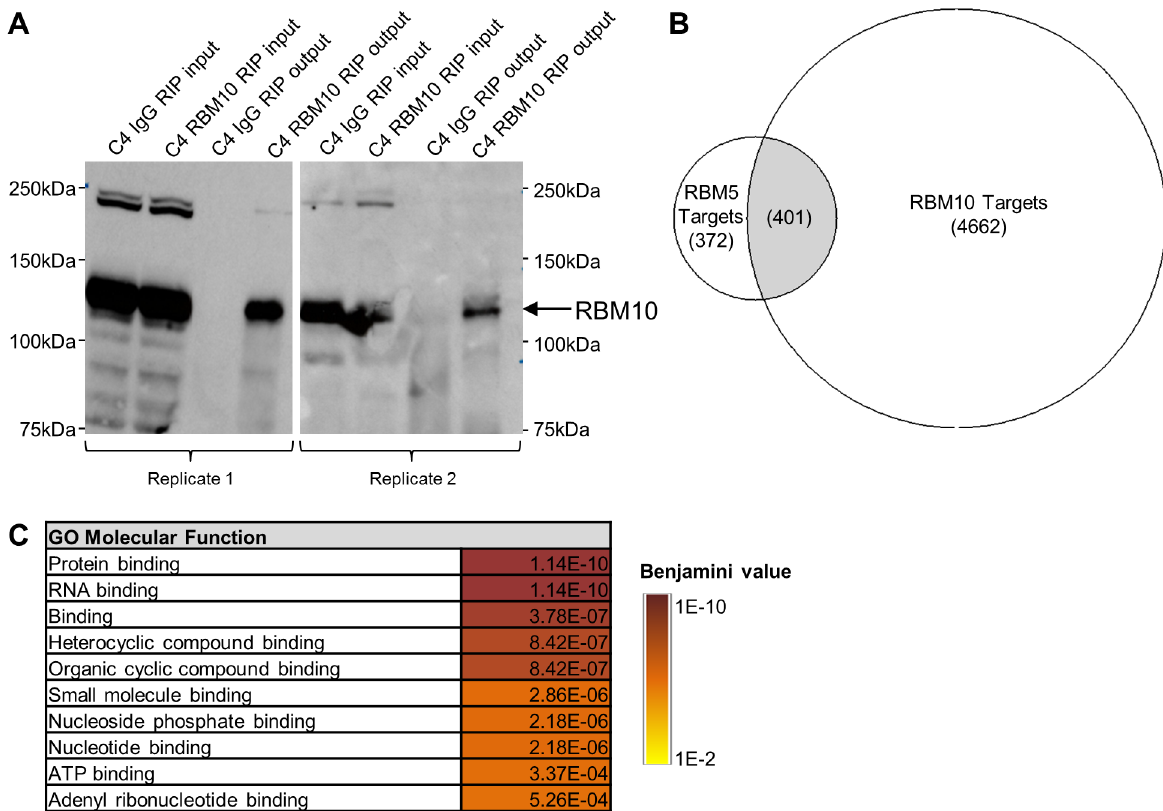
Fig 2. RBM10 RIP-Seq results and comparison to identified RBM5 targets. (A) Successful immunoprecipitation of RBM10 from C4 cells, demonstrated by Western blot of input and output protein samples. Blots probedfor RBM10, using the same RBM10 antibody used in the immunoprecipitationexperiment (Sigma-Aldrich). Controlimmunoprecipitationperformed, using a non-specific rabbit IgG antibody. (B) Overlap between RBM5 and RBM10 targets in C4 GLC20 subline.(C) GO MolecularFunction gene sets enrichedin common RBM5 and RBM10 RIP-Seq targets, as determined by FIDEA. Valuesindicatedare Benjamini values.